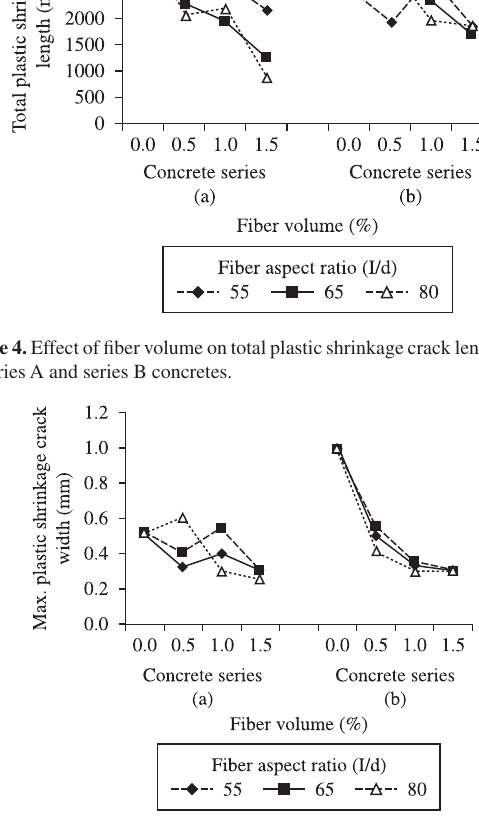
Figure 5. Effect of fiber volume on maximum plastic shrinkage crack width (mm), for series A and series B concretes.